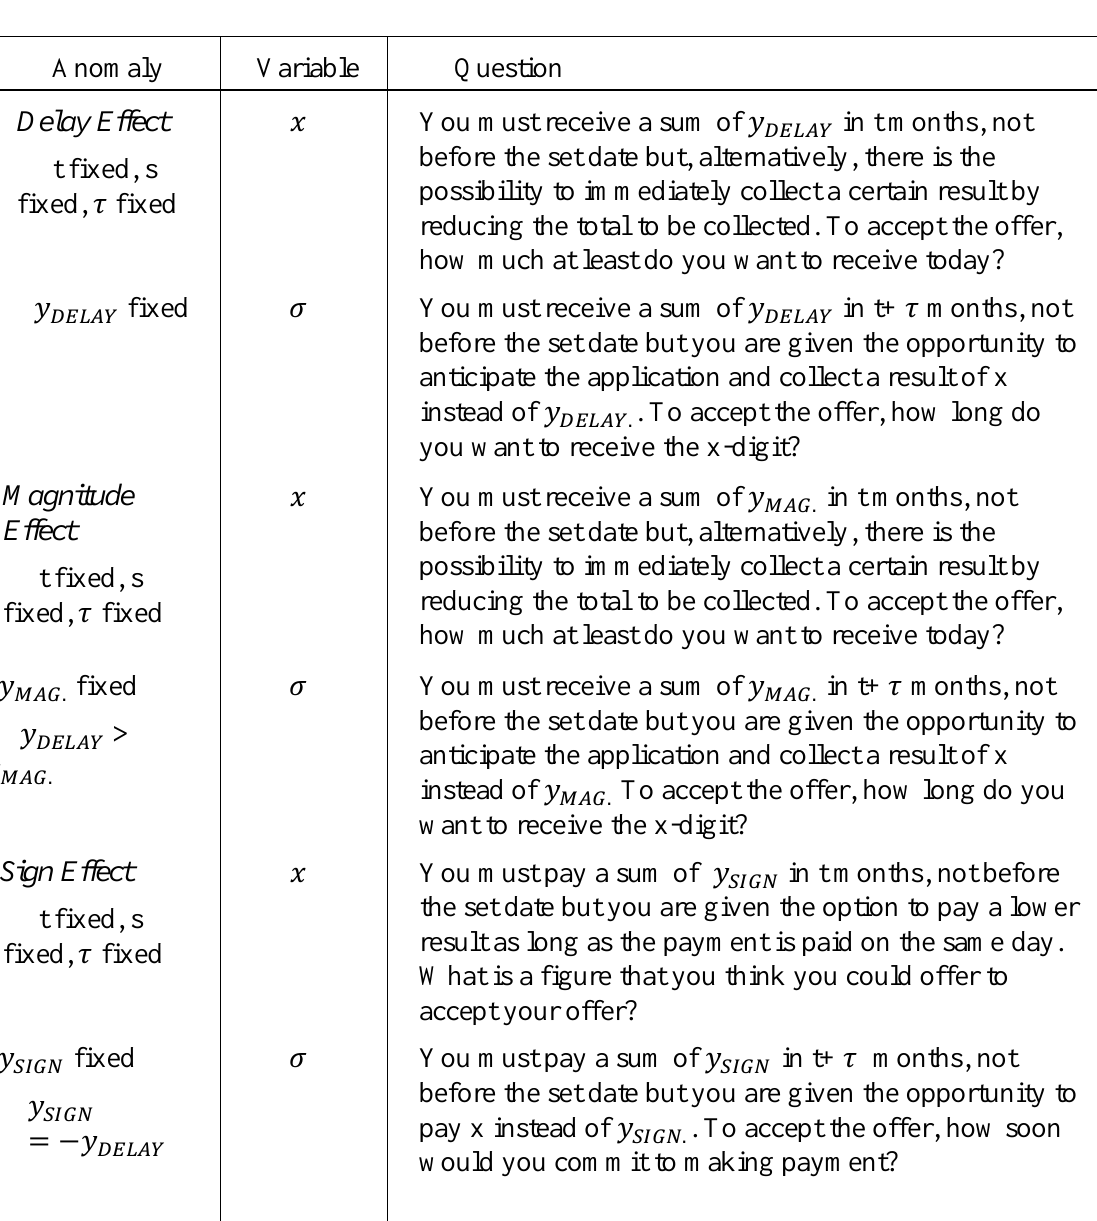
Table 5: Questions to obtain the pairwise comparison matrices between temperaments and